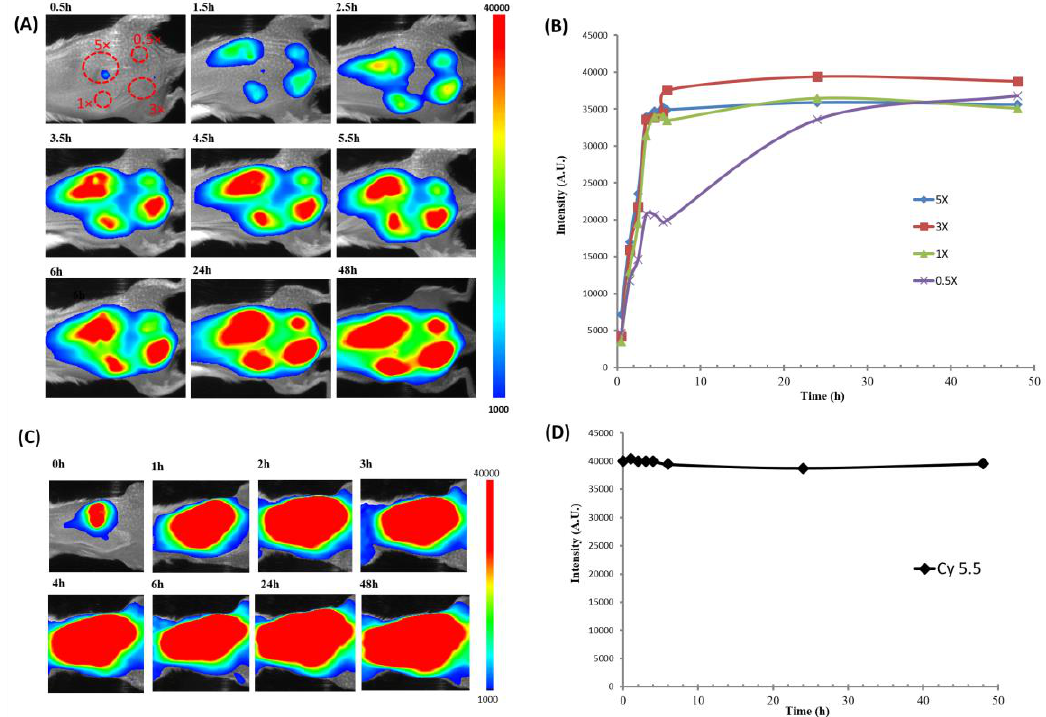
Figure 6. ADP(CA) 2 solutions with four different concentrations or Cy5.5 solution were injected subcutaneously in the back of animals. ( A ) In vivo fluorescence images of ADP(CA) 2 at different time points; ( B ) The mean fluorescence intensities of ADP(CA) 2 at the four injection sites as a function of time; ( C ) In vivo fluorescence images of Cy5.5 at different time points; ( D ) The mean fluorescence intensity of Cy5.5 as a function of time; Those fluorescence images were taken using KODAK In Vivo FX Pro system (f-stop: 2.5, excitation filter: 630 nm, emission filter: 700 nm, 4 × 4 binning; Carestream Health, Rochester, NY, USA). All data analyses were performed using Carestream Molecular Imaging